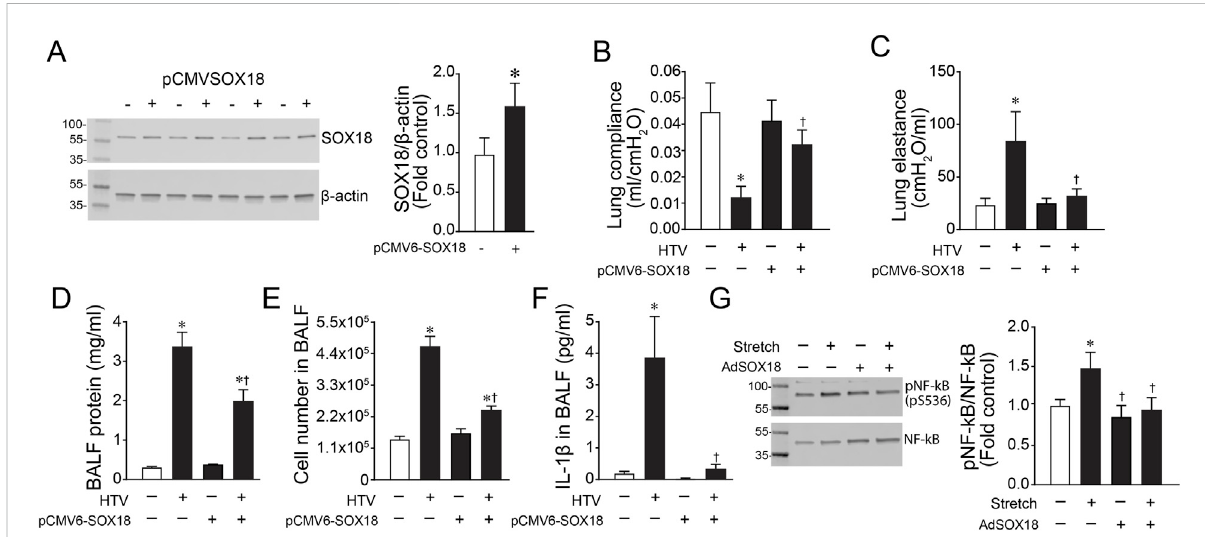
FIGURE 6 The over-expression of Sox18 preserves lung mechanics in mice exposed to high tidal mechanical ventilation. Mice were injected or not with pCMV6-SOX18 (SOX18) or control pDST-luciferase plasmids using in vivo-jetPEI ® via the tail vein. After 64 h, the mice were exposed or not to ventilation with high tidal volumes (HTV; 30 ml/kg, 75 bpm, 0.5 FiO2) for 8 h. HLMVECs were treated with AdSOX18 for 48 h to overexpress SOX18 andsubjectedtocyclicstretchfor8h.Immunoblotanalysisdemonstratedasigni fi cantincreaseinSox18proteinlevelsinthelungsofmicegiven the pCMV6-SOX18 plasmid (A) . The analysis of dynamic pressure-volume relationships in the mouse lung indicated that HTV ventilation caused a loss of Optimal Respiratory System Compliance (B) and Respiratory System Elastance (C) which is prevented in SOX18 over-expressing mice. SOX18 over-expression attenuated the increase in BALF protein concentration in mice exposed to HTV (D) . Total cell count in the bronchoalveolar lavage fl uid (BALF) was elevated after HTV exposure, and this was signi fi cantly decreased by SOX18 over-expression (E) . IL-1 β secretion in the BALF was increased with HTV treatment, which was ameliorated by SOX18 overexpression (F) . Immunoblotting analysis of HLMVECs showed that overexpressionofSOX18reducedthecyclicstretch-inducedincreaseinpS536-NF-kB (G) .* p < 0.05versusControl, † p <